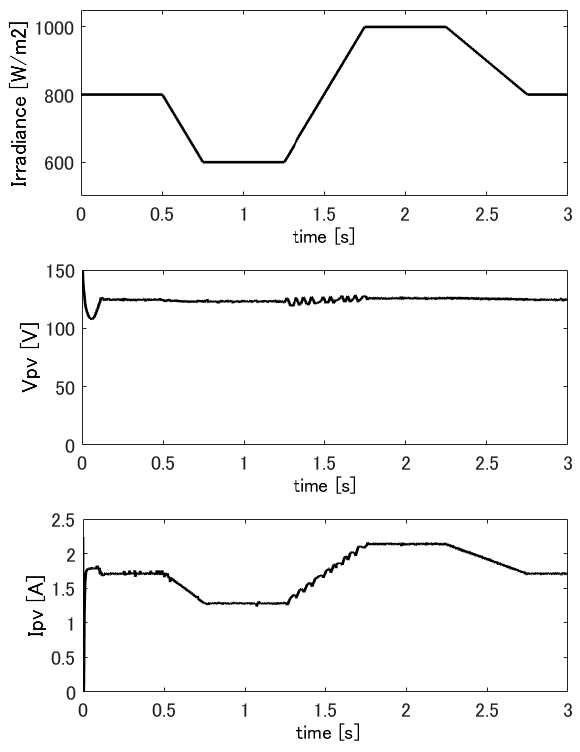
Figure 17. Responses of the P&O control with the varying irradiance. Energies 2018 , 11 , x FOR PEER REVIEW